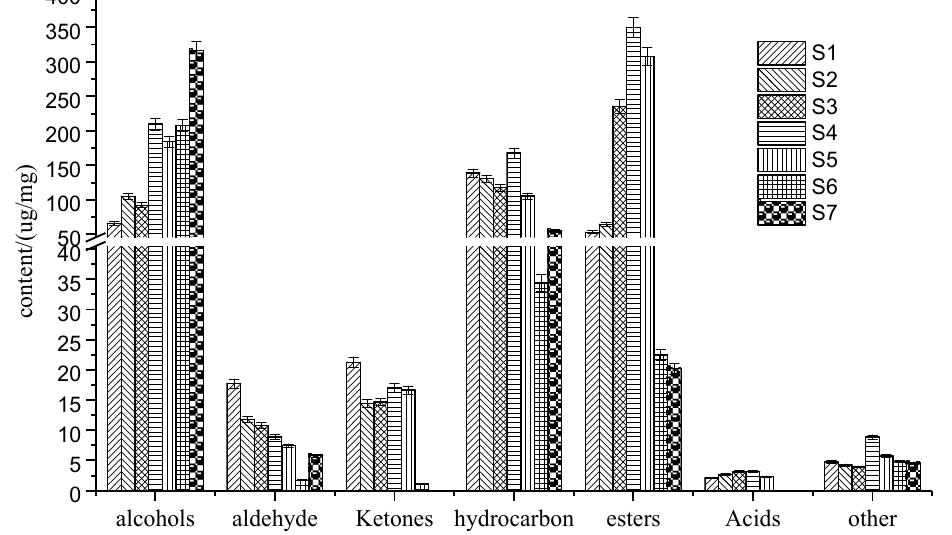
Figure 2. The comparison of the volatile components of seven kinds of pepper oil.